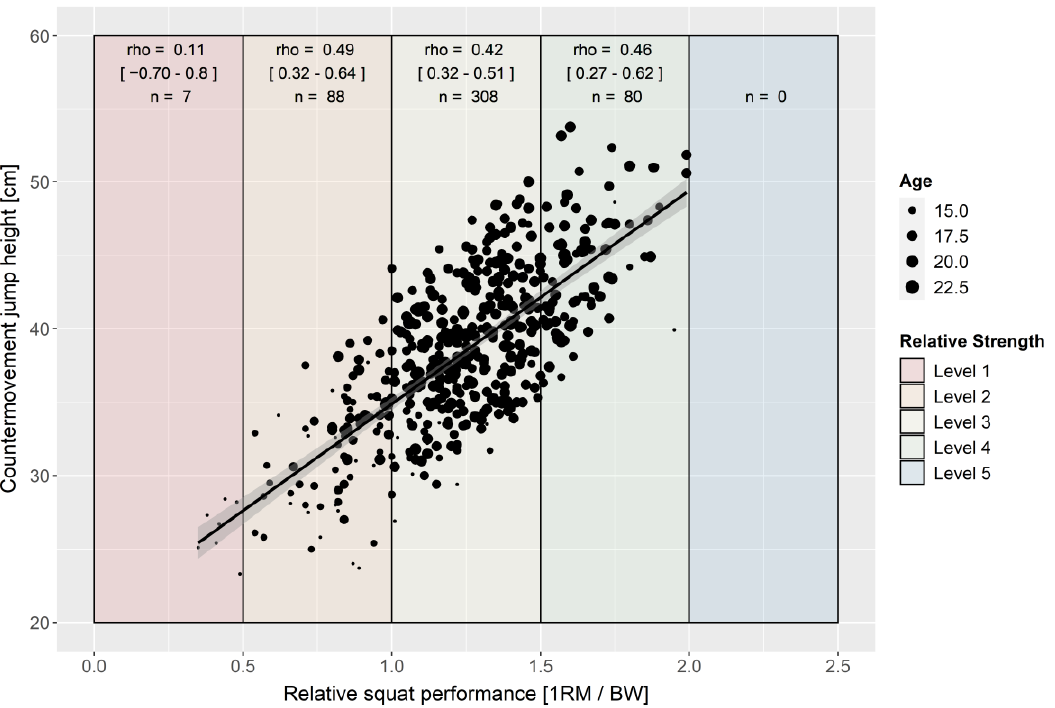
Figure 2. Scatterplot for relative squat and countermovement jump performance with trendline and 95% confidence interval (rho = 0.72 [ p < 0.001; 95% CI = 0.67 – 0.76]; r partial = 0.69 [CI95% = 0.64 – 0.73]; n = 483).